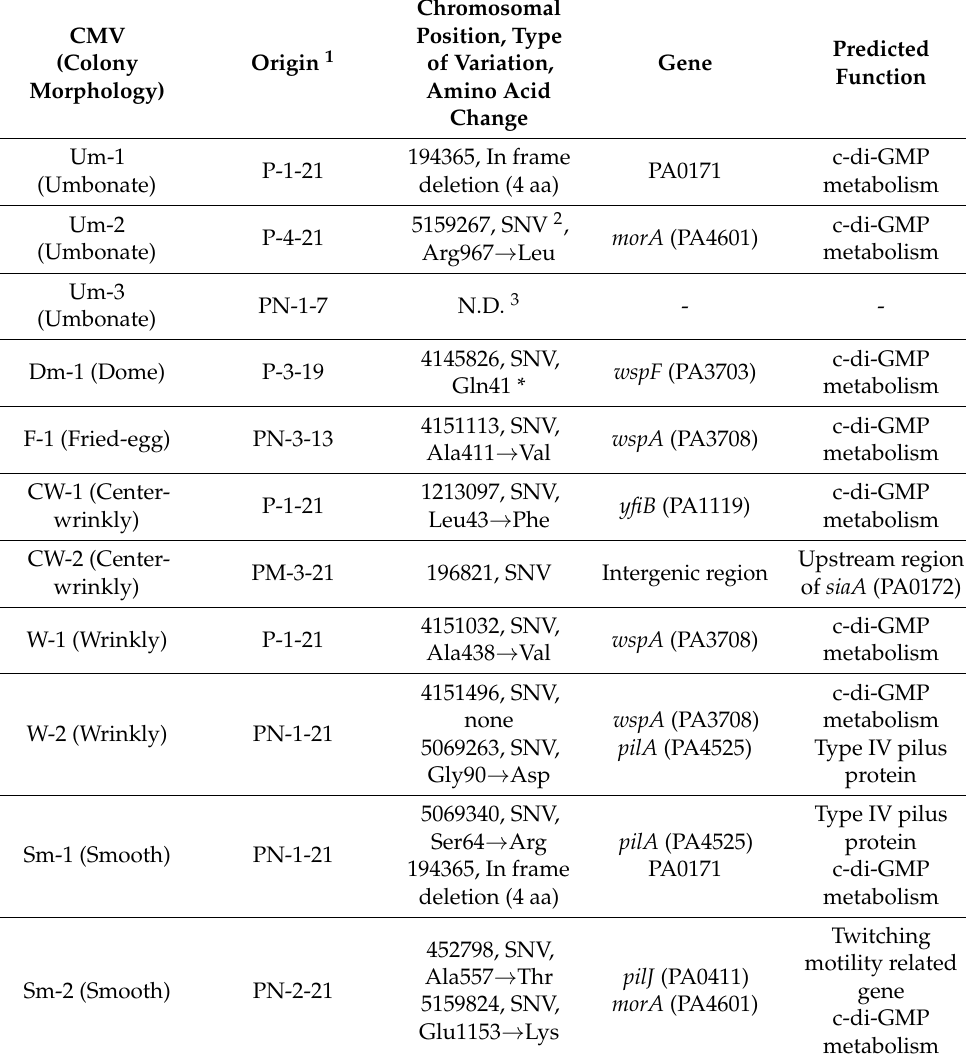
Table 1. Nucleotide variants in the genomes of isolated